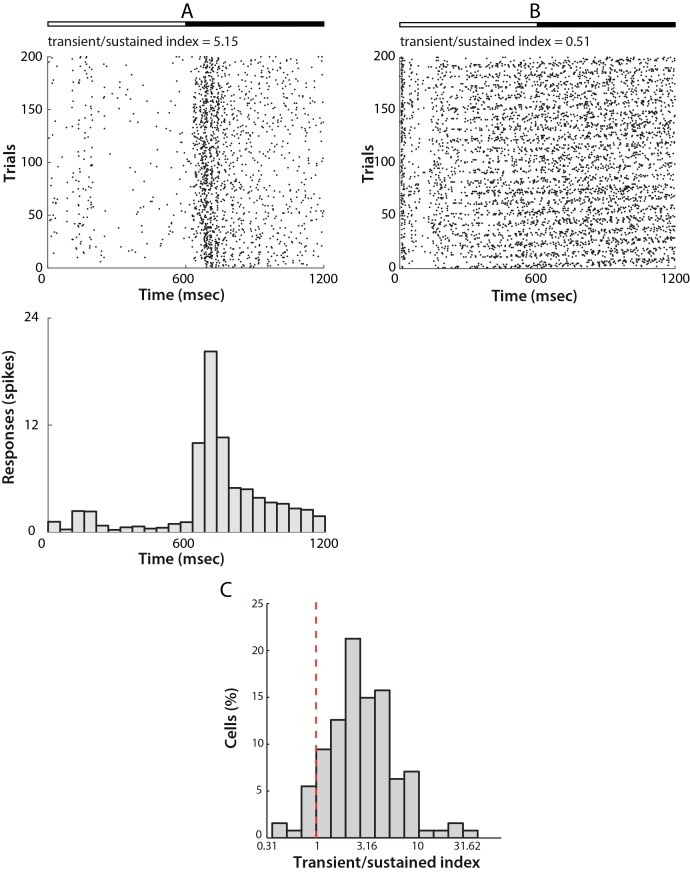
Transient/sustained responses of mouse LGN neurons.A) An example of a cell that responded transiently to a flicker stimulus. The top bar represents stimulus onset, with full-field white stimulation starting at time 0 msec and changing to a black stimulation starting from 600 msec and persisted for another 600 msec. The middle panel shows the raster plot of the cell’s response for all trials represented in the Y-axis against time in the X-axis. The bottom panel shows the PSTH of the same response in 50 msec. bins. B) A cell that responded in a sustained manner to the same stimulus. All parameters as in A. C) Distribution of the transient/sustained index across the population of cells. The red dashed line indicates the threshold for classifying cells as either sustained (<1) and transient (>1). The majority of the cells in our dataset (121 out of 127, 95.3%) responded transiently.